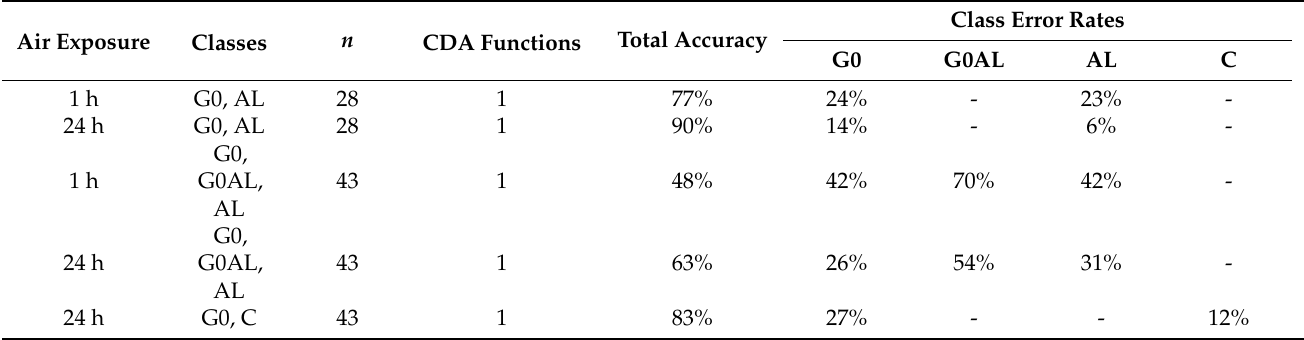
Table 7. Performances in 5-fold cross-validation with 50 repeats of the canonical discriminant analysis (CDA) models developed to discriminate beef according to animal production systems using colour variables (L*, a* and b*) after 1- or 24-h aerobic exposure.